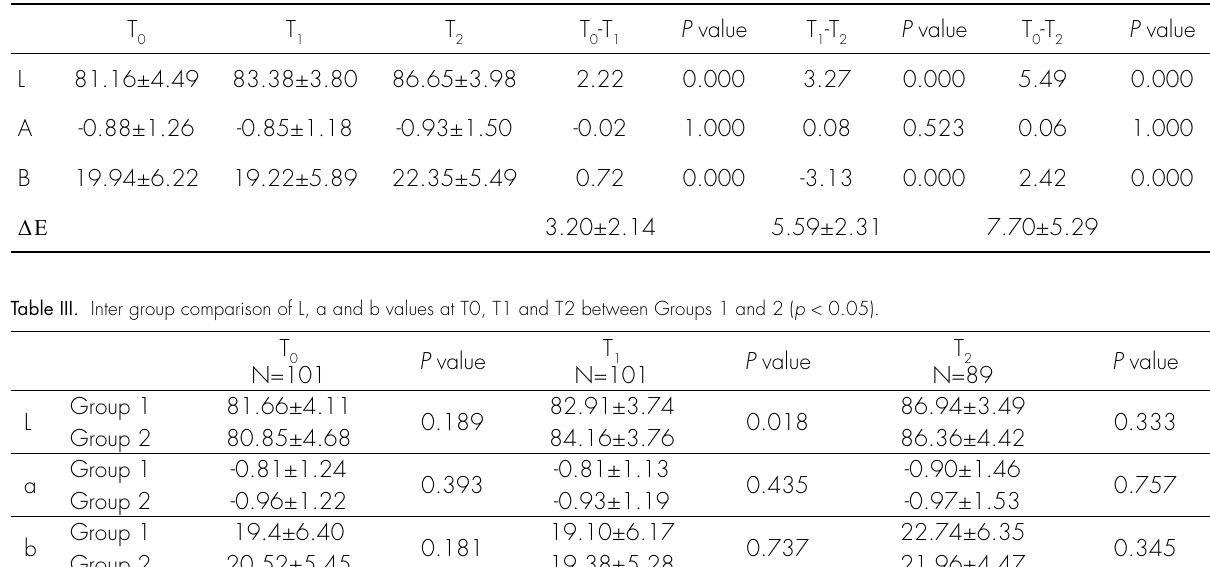
Table II. Mean CIE values at T0, T1, and T2 and ΔΕ ( ΔΕ 1, ΔΕ 2 & ΔΕ 3) for all studied teeth (N = 178)( p < 0.05).